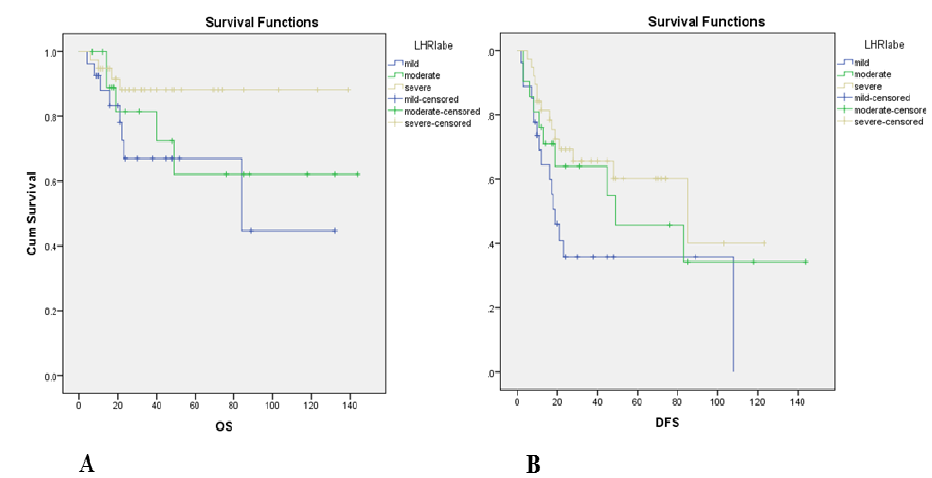
Fig. 4. Relation of overall survival (OS) (A) and disease free survival (DFS) on lymphocyte host response